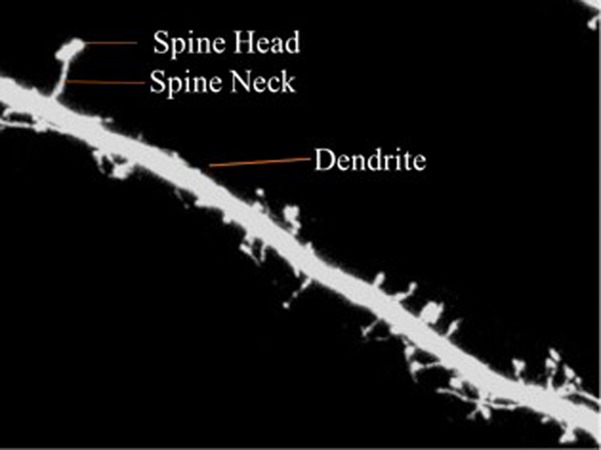
Dendritic spine.